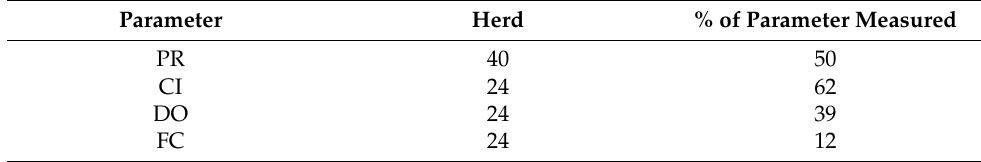
Table 4. Summary of reproductive performance of smallholder beef cows at provincial level. Table 3. Summary of reproductive performance of smallholder beef cows at national level.